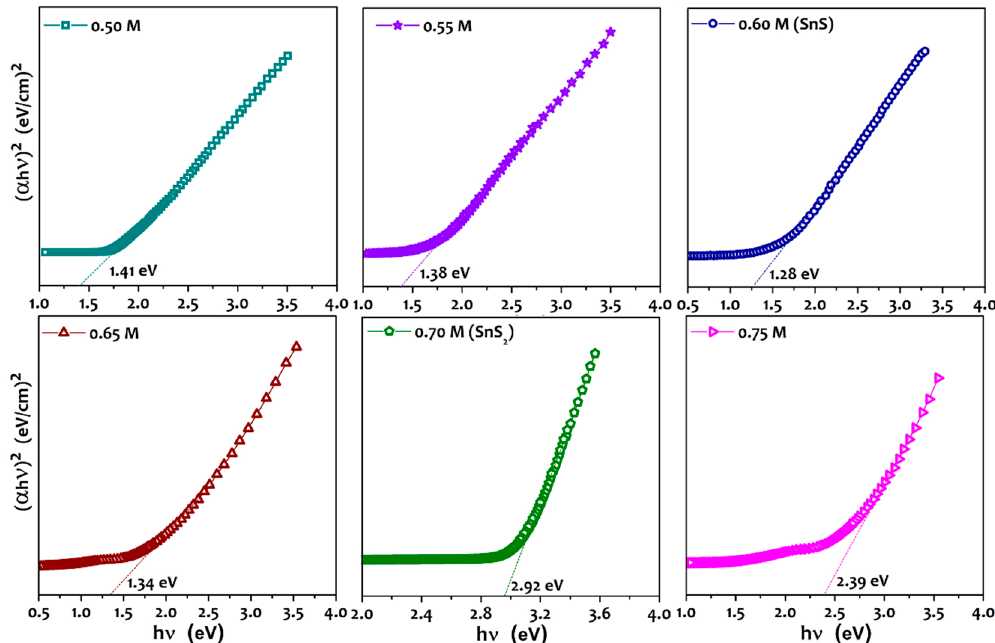
Figure 6. Tauc’s plots of the films deposited at di ff erent TA concentrations.